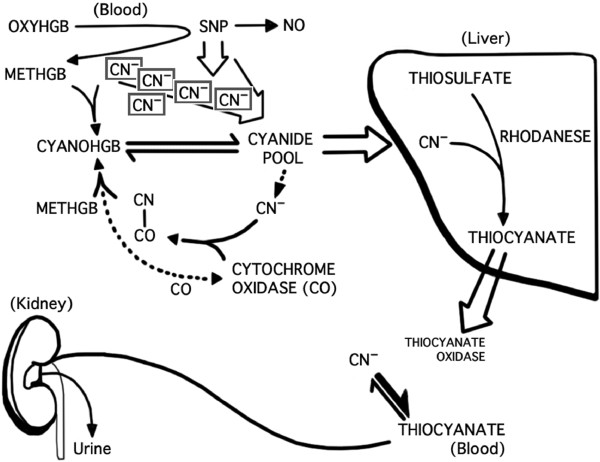
SNP metabolism. *SNP = sodium nitroprusside; CN- = cyanide; NO = nitric oxide; METHGB = methemoglobin; CYANOHGB = cyanohemoglobin; OXYHGB = oxyhemoglobin. *Modified with permission from Figure 1[2].